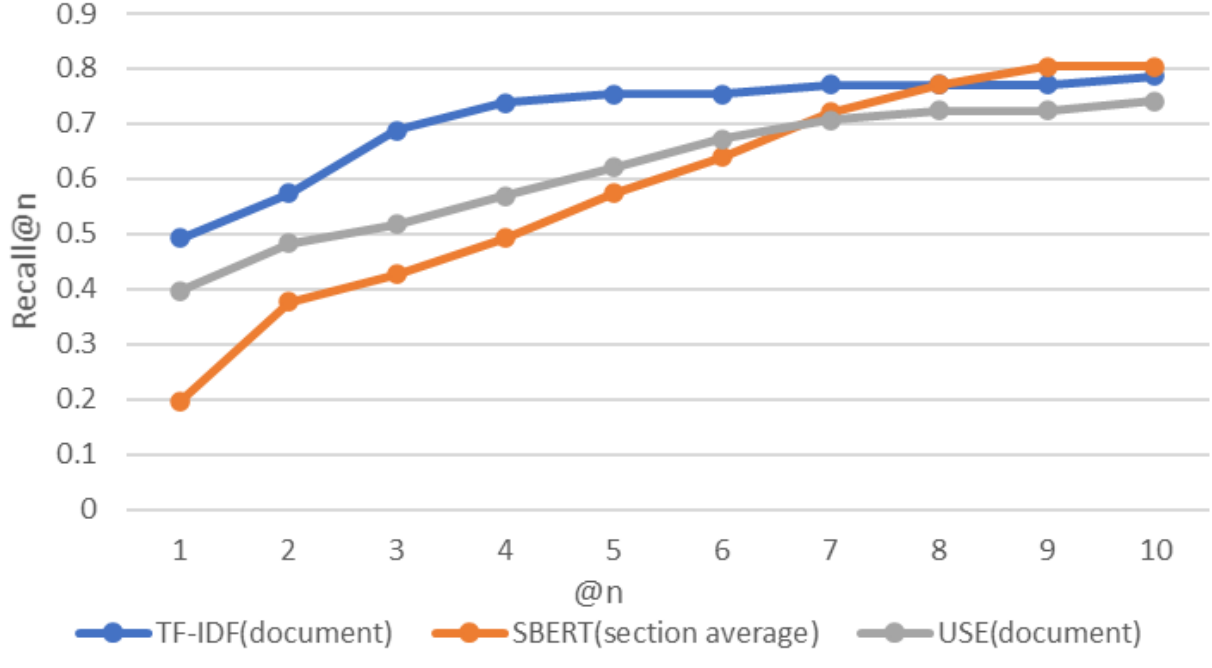
Figure 11. Recall for each approach.